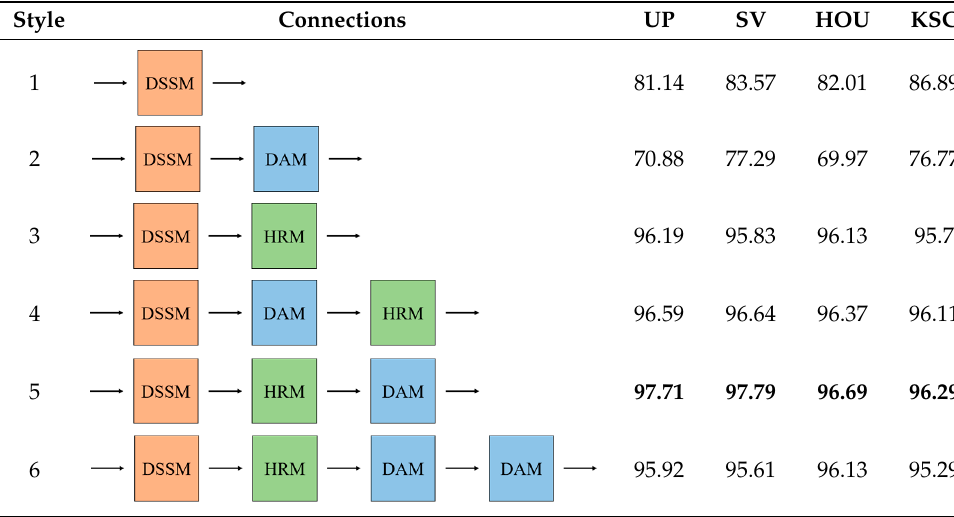
Table 9. OAs (%) with different styles of connections using three modules.